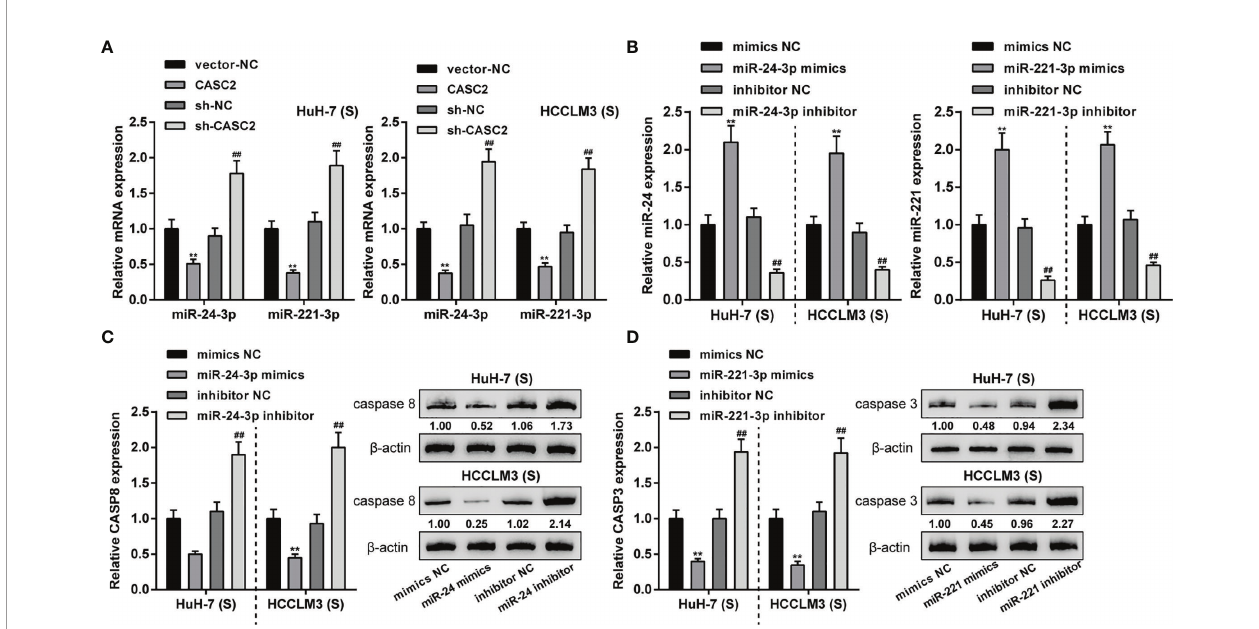
FIGURE 4 | LncRNA CASC2 regulates caspase-8 and caspase-3 by targeting miR-24/221. (A) Huh-7 (S) and HCCLM3 (S) cells were transfected with CASC2 or sh-CASC2 and examined for the expression of miR-24 and miR-221 expression using qRT-PCR. (B) miR-24/miR-221 overexpression or inhibition was achieved in Huh-7 (S) and HCCLM3 (S) cells by transfecting miR-24/miR-221 mimics or inhibitor; transfection ef fi ciency was con fi rmed using qRT-PCR. (C) Huh-7 (S) and HCCLM3 (S) cells were transfected with miR-24 mimics or inhibitor and examined for caspase-8 protein using Immunoblotting. (D) Huh-7 (S) and HCCLM3 (S) cells were transfected with miR-221 mimics or inhibitor and examined for caspase-3 protein using Immunoblotting. **p < 0.01, compared with vector-NC or mimics NC group, ## p < 0.01, compared with sh-NC or inhibitor NC